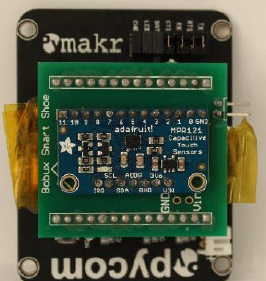
Figure 15. PCB shield assembled on top of the Pycom Expansion Board.